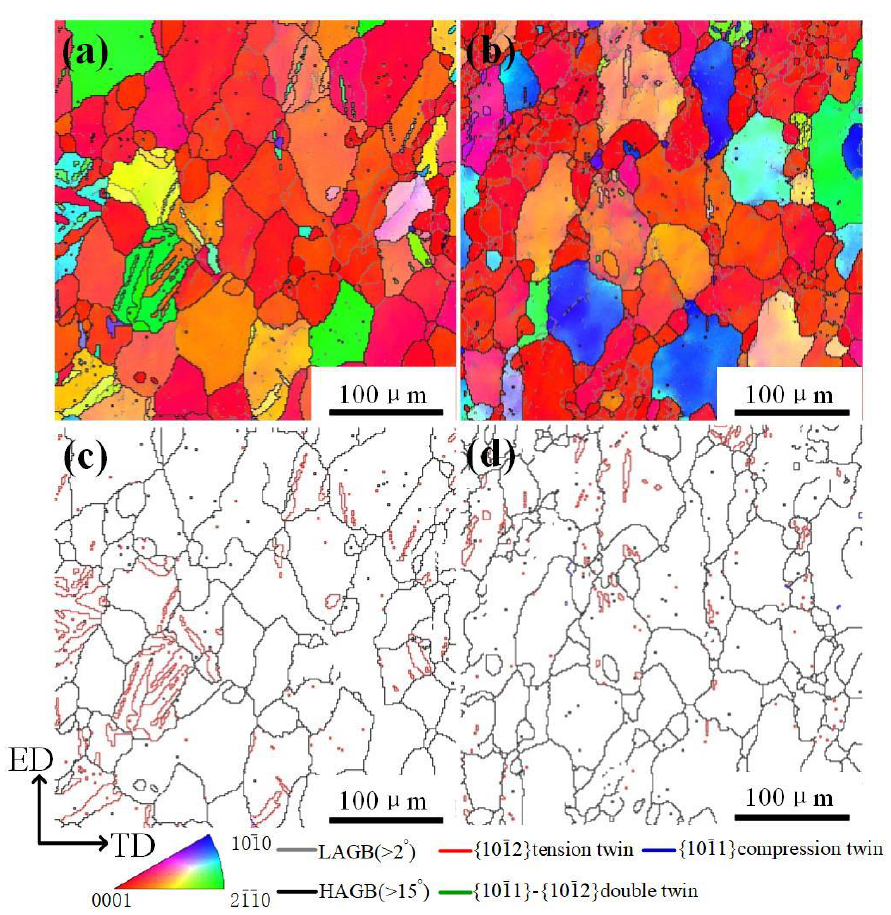
Figure 4. ( a , b ) IPF images and ( c , d ) twin distribution of ( a , c ) 8% strain and ( b , d ) 24% strain under 20 A/mm 2 .